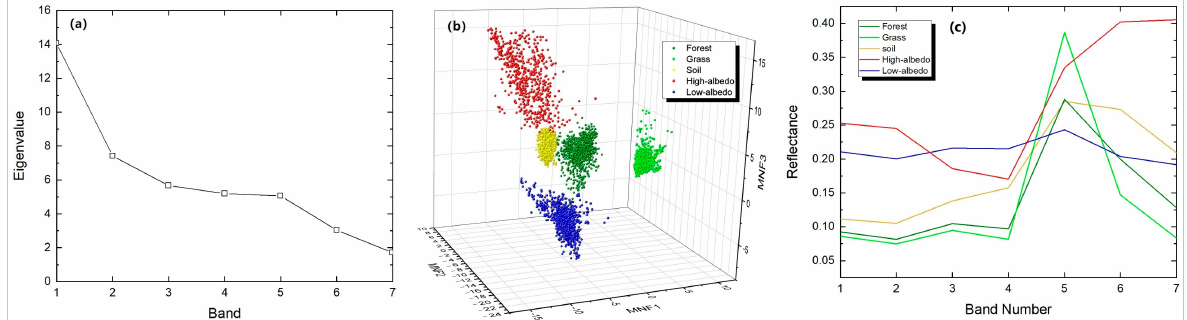
Figure 3. Endmember selection (data of 28 April 2020). ( a ) Eigenvalues of all minimum noise fraction rotation (MNF) bands; ( b ) 3D scatter plot of each endmember in MNF bands 1–3; and ( c ) response curve of all endmembers at each